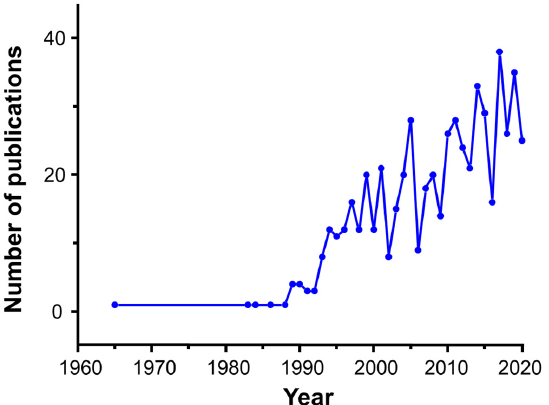
Figure 1. Evolution of number of publications containing references to OMS materials. Source: Compilation based on Scopus data (March 2021).